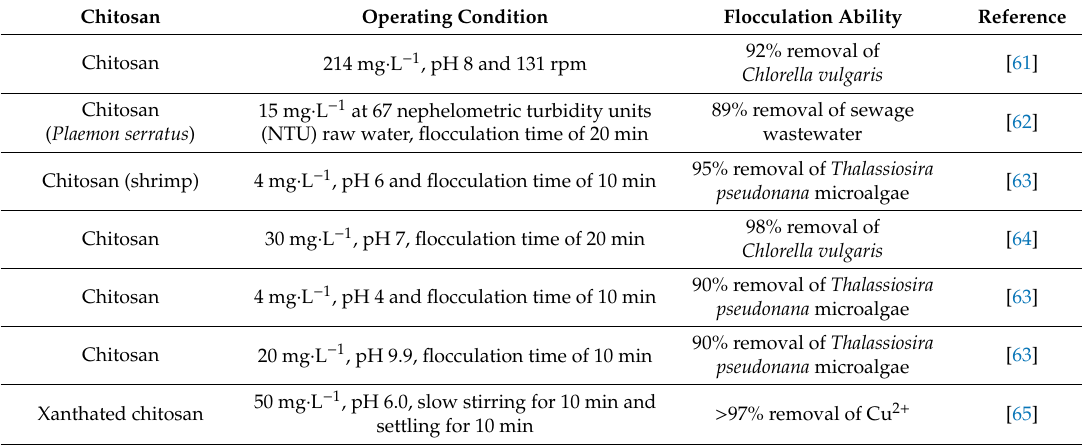
Table 2. Flocculation abilities of chitosan at its best conditions to separate various pollutants from the aqueous